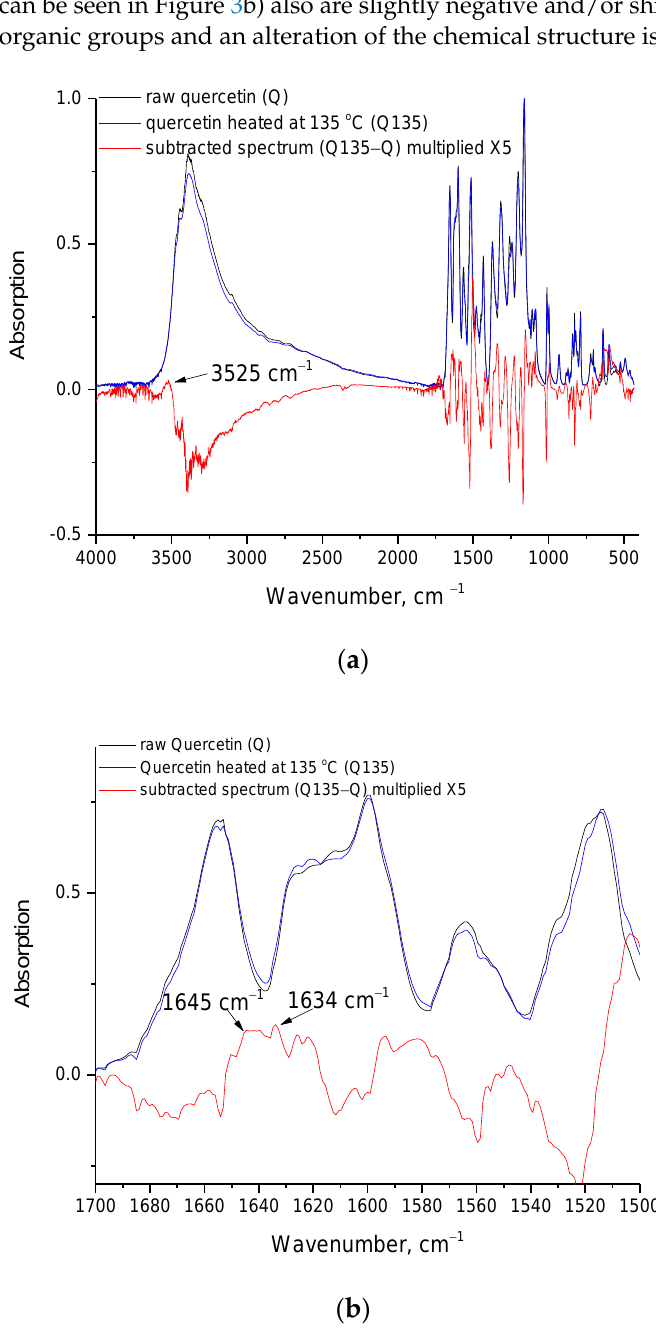
Figure 3. FTIR spectra of raw quercetin (Q) and quercetin heated at 135 °C (Q135) and their subtracted spectrum (Q135-Q) in the range: ( a ) 400 – 4000 cm −1 , and ( b ) 1500 – 1700 cm −1 .